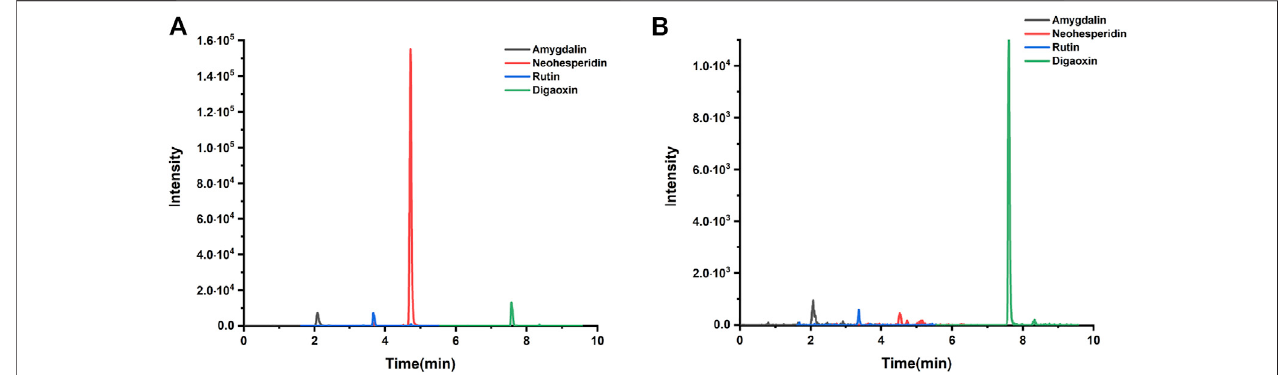
FIGURE 1 | Qualitative analysis. (A) Amygdalin, neohesperidin, rutin, and digaoxin of standard agents detected by LC chromatogram. (B) Amygdalin, neohesperidin, rutin, and digaoxin of XFZYD in plasma samples post-CCI.